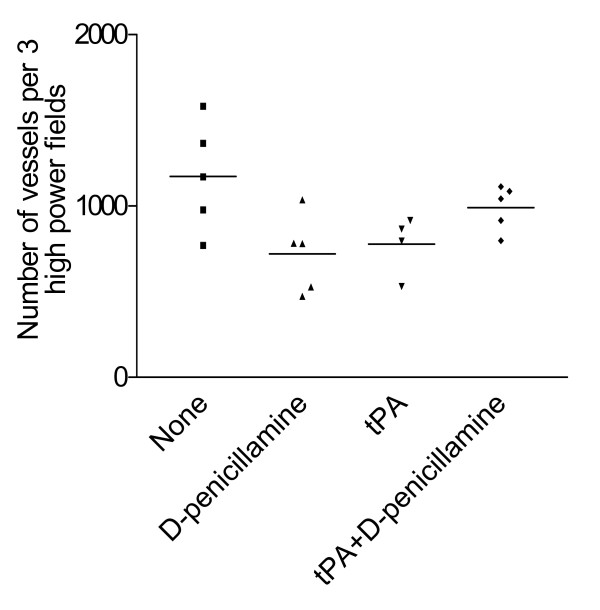
Treatment effects on the amount of tumor vessels. In tissue sections from BLM tumors derived from mice treated with tPA and/or D-penicillamine, blood vessels were stained with rat-anti-mouse-endothelial cell antibody 9F1, and quantified. Although a reduction in vessel density was observed after either treatment, these reductions did not reach statistical significance.